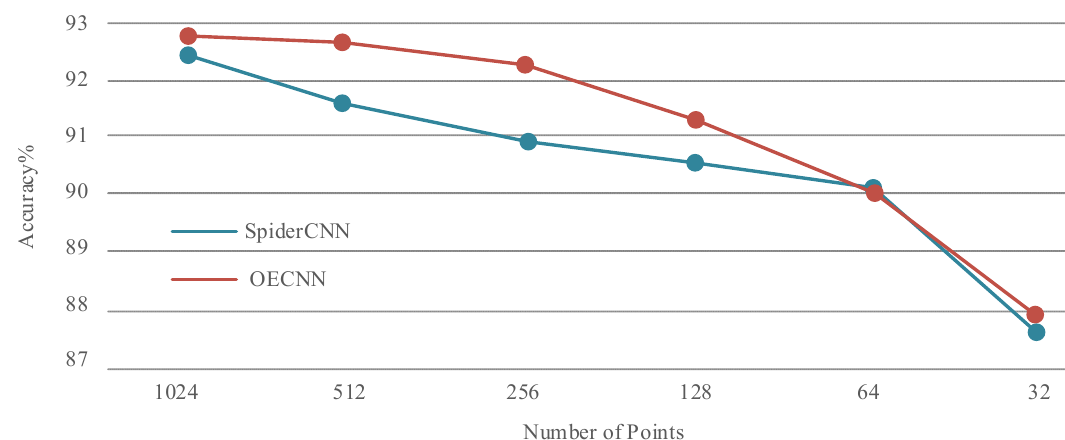
Figure 11. Qualitative results of part segmentation.